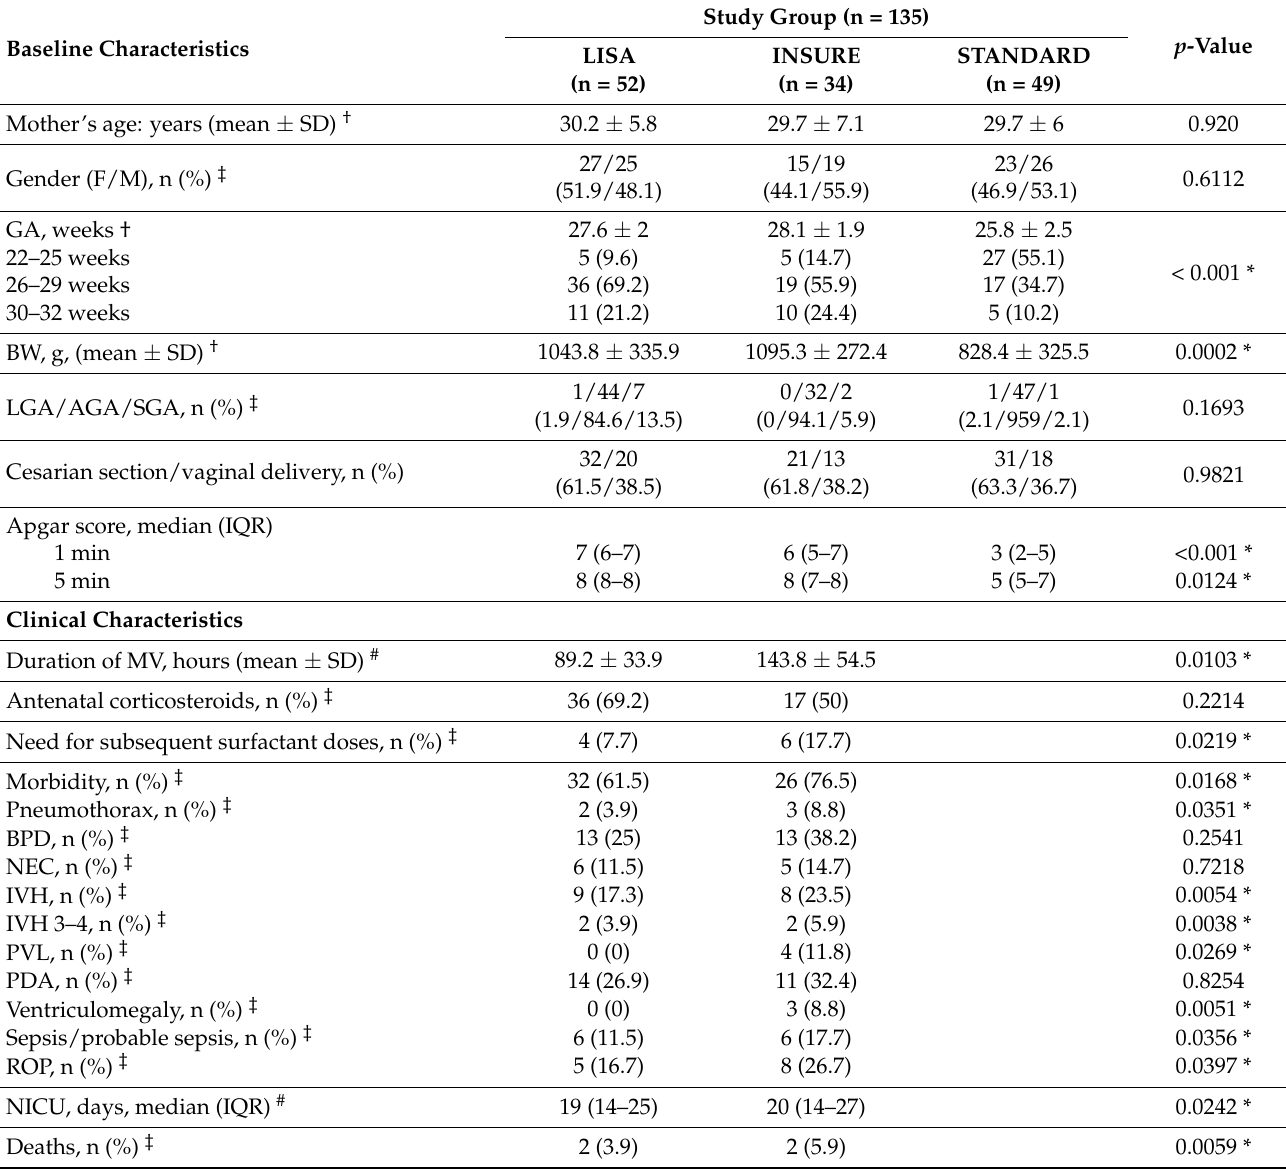
Table 1. Comparison of clinical characteristics between the groups depending on the method of administration of the